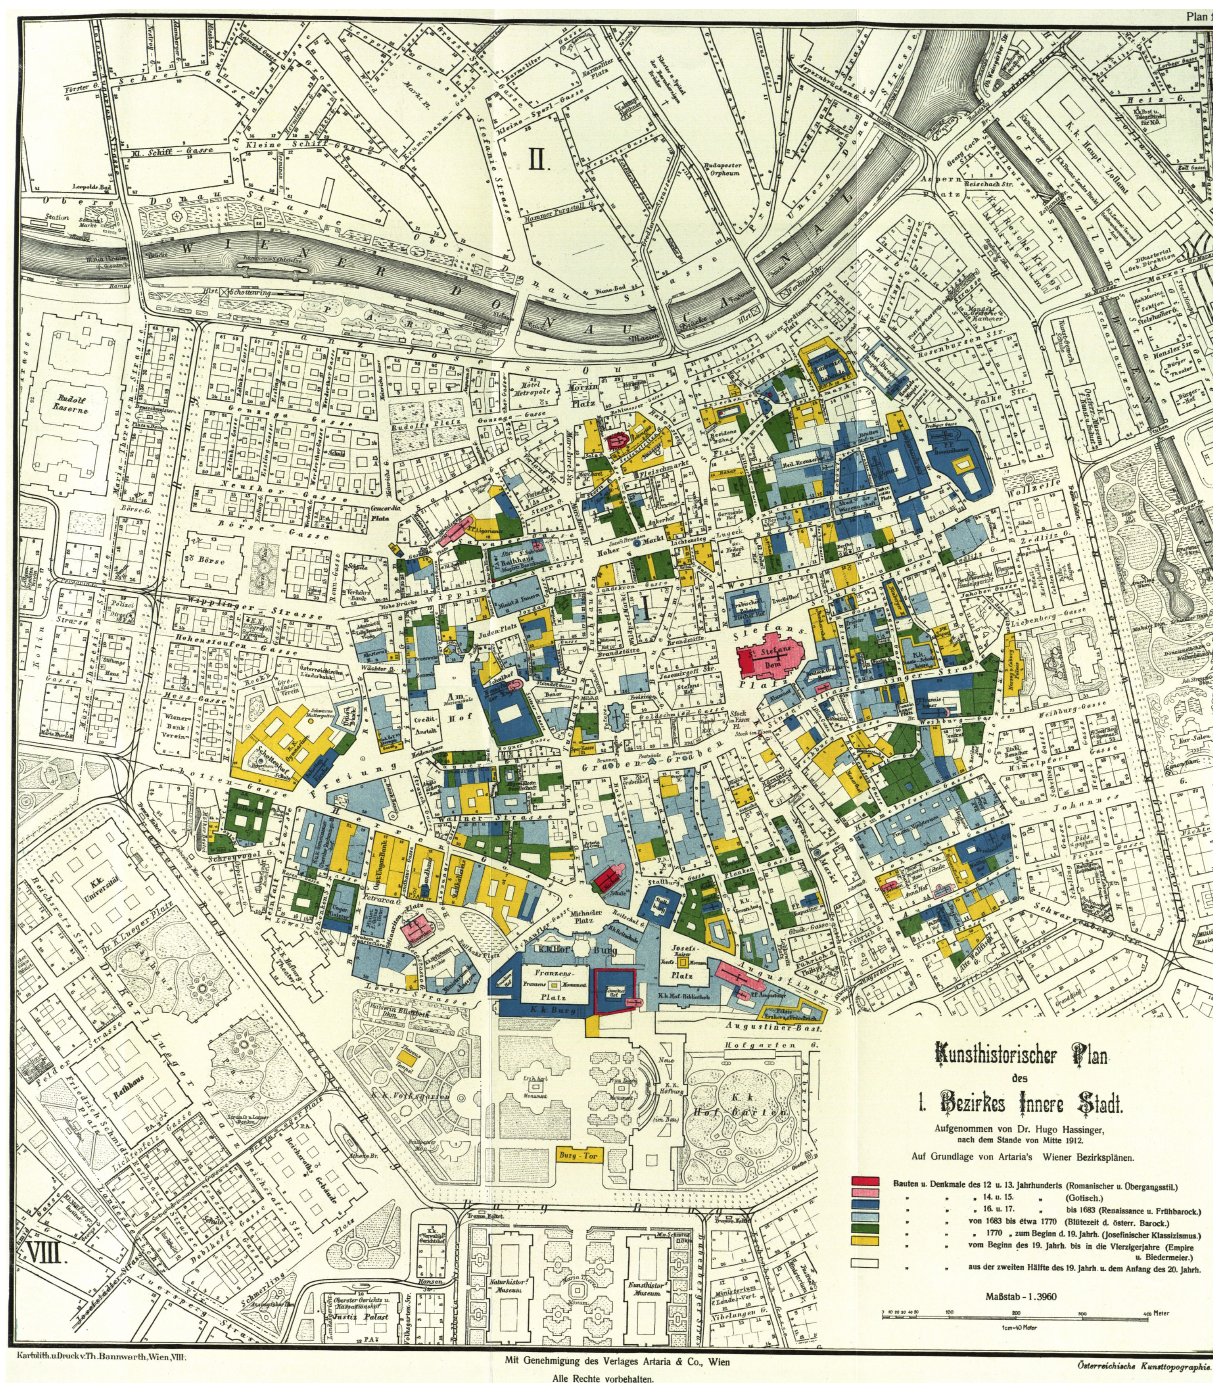
Figure 2. Hugo Hassinger’s “Kunsthistorischer Plan des 1. Bezirkes Innere Stadt”: The map shows the area in 1912 and